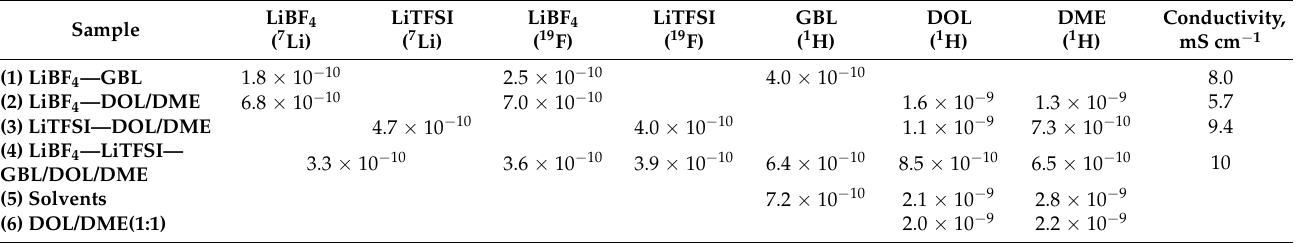
Table 2. Self-diffusion coefficients on 7 Li, 19 F, and 1 H (m 2 s − 1 ) and experimental conductivity at room